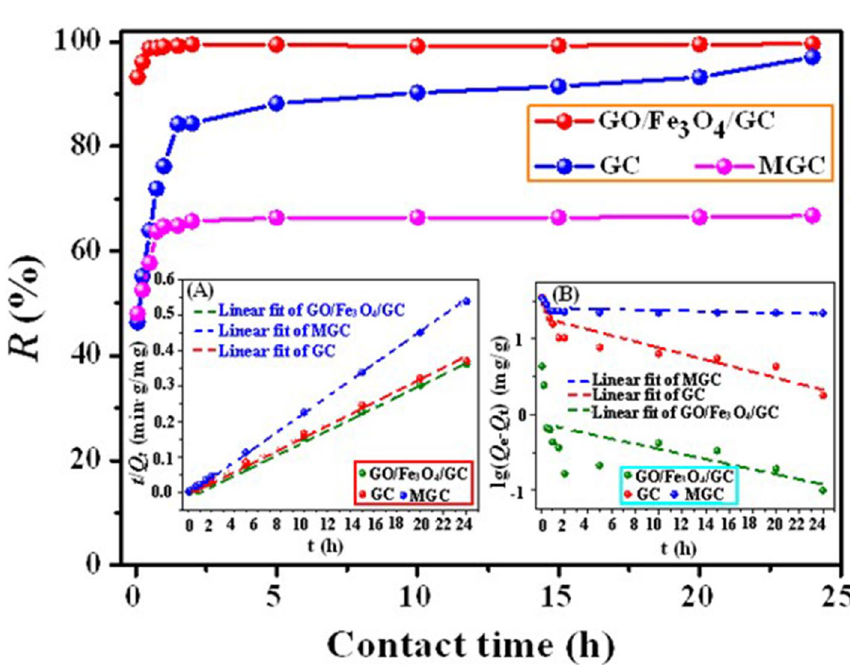
Figure 7. Influence of contact time on U(VI) sorption by GC, MGC and GO/Fe 3 O 4 /GC. Insert A and B are linear fit of the pseudo first-order and pseudo second-order kinetics models, respectively. pH = 5.0 and 6.0, C (U)initial = 10 mg L −1 , and C adsorbent = 0.15 g L −1